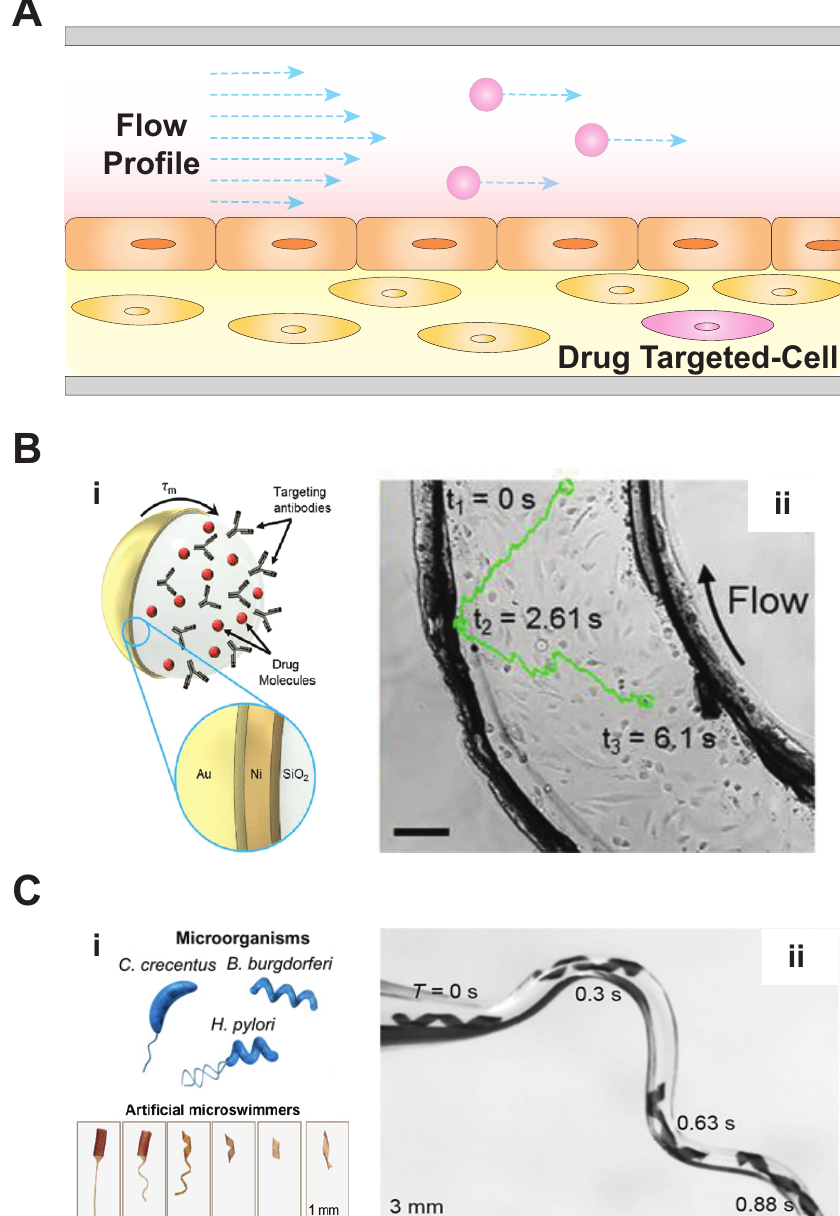
Figure 3. Microbiorobot motility and its relevance to organ-on-a-chip systems. ( A ) Microbiorobots (MBRs) will need to navigate within the laminar fluid regime generated in microvessels in order to precisely deliver drugs to a target. ( B ) Multifunctional microrollers have been engineered with ( i ) antibodies to target and bind cancer cells present in endothelialized surfaces. The microrollers were able to resist ( ii ) disturbances from physiological fluid flow (scale bar, 100 µ m) [12]. Images reproduced with permission from Alapan et al. Science Robotics , 2020. ( C ) In another approach, ( i ) biologically inspired microswimmers were maneuvered through ( ii ) tortuous glass microchannels, demonstrating the feasibility of MBR delivery in the vasculature [7]. Images reproduced with permission from Huang et al. Science Advances ,